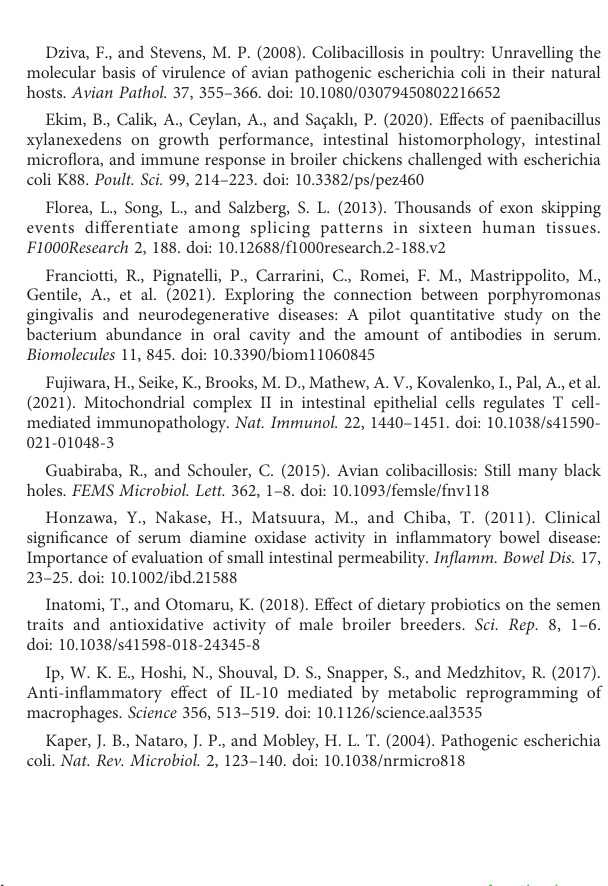
SUPPLEMENTARY FIGURE 1 A KEGG map of the oxidative phosphorylation pathway of DEGs in CG vs EG. CG=control group, non-challenged with pathogenic E. coli O88; EG=experiment group, challenged with pathogenic E. coli O88. The boxes withgreenframescorrespondtothedown-regulationofDEGsintheEGducks. SUPPLEMENTARY FIGURE 2 A KEGG map of the ribosomal pathway of DEGs in CG vs EG. CG=control group, non-challenged with pathogenic E. coli O88; EG=experiment group, challenged with pathogenic E. coli O88. The boxes with green frames correspond to the down-regulation of DEGs in the EG